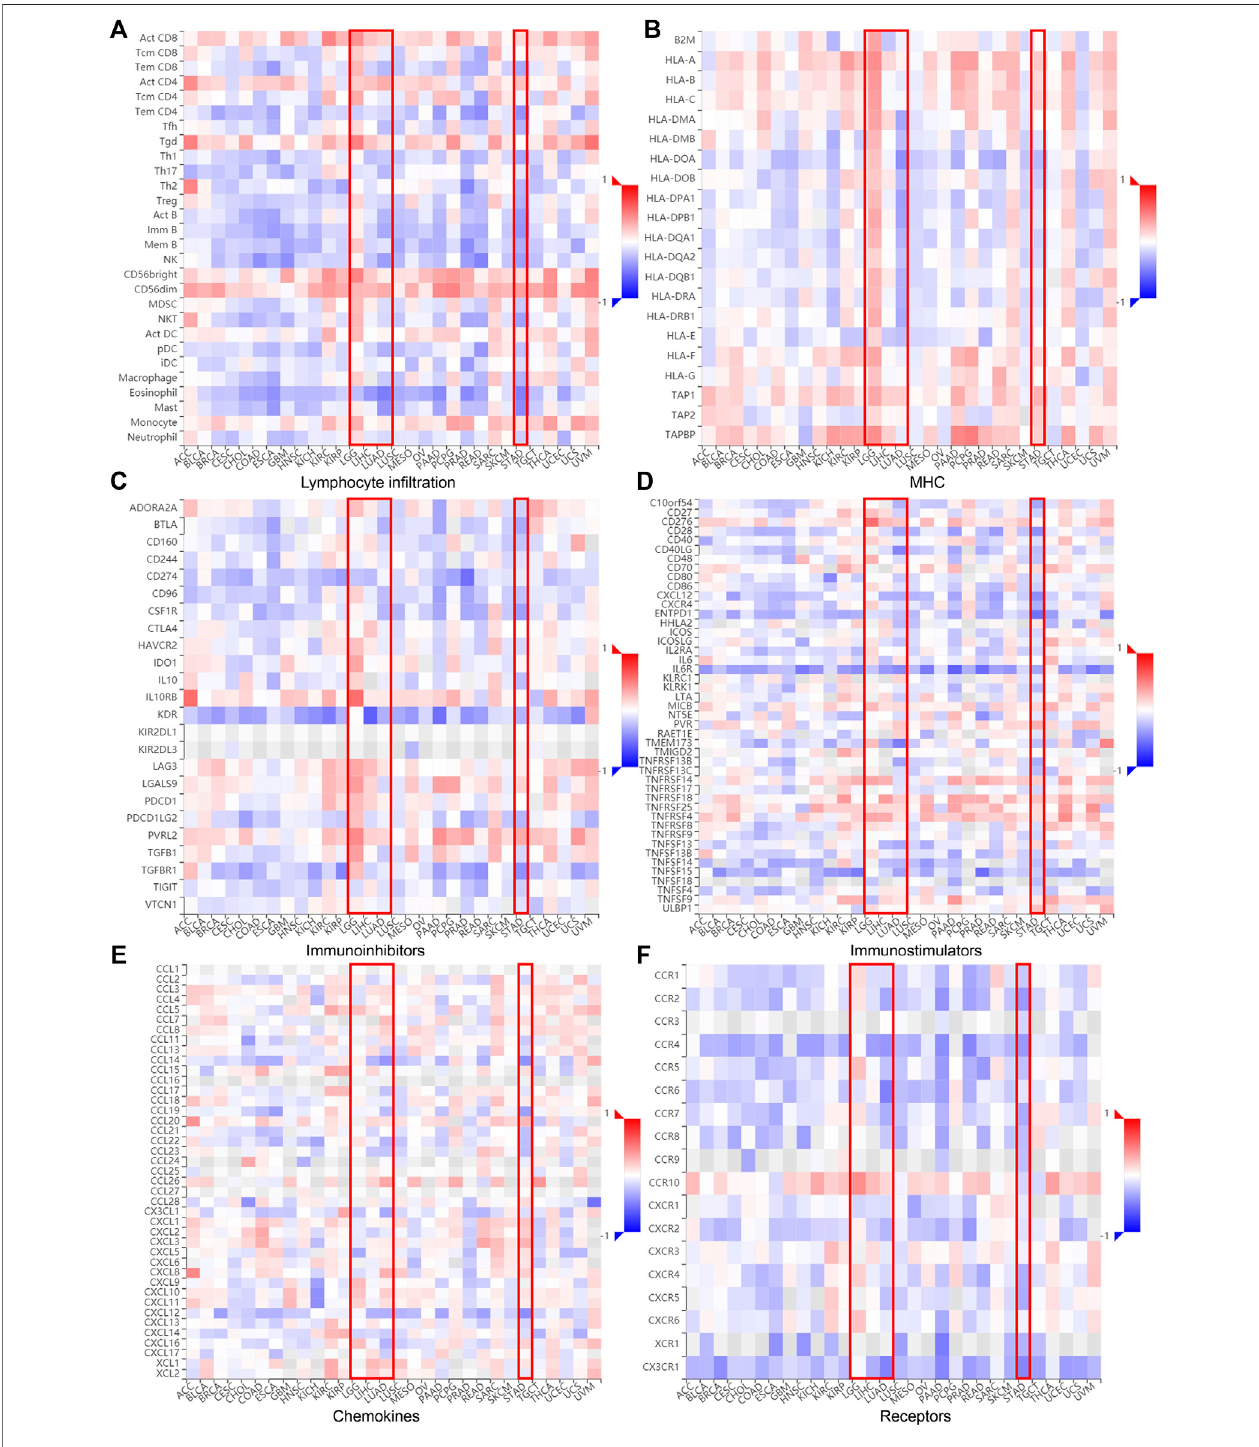
FIGURE 6 | DTYMK expression is linked to immune in fi ltration as analyzed using the TISIDB database. DTYMK expression affected lymphocyte in fi ltration (A) , MHC expression (B) , immune inhibitors expression (C) , immunostimulatorexpression (D) , chemokine expression (E) and chemokine receptors expression (F) inhuman cancers.